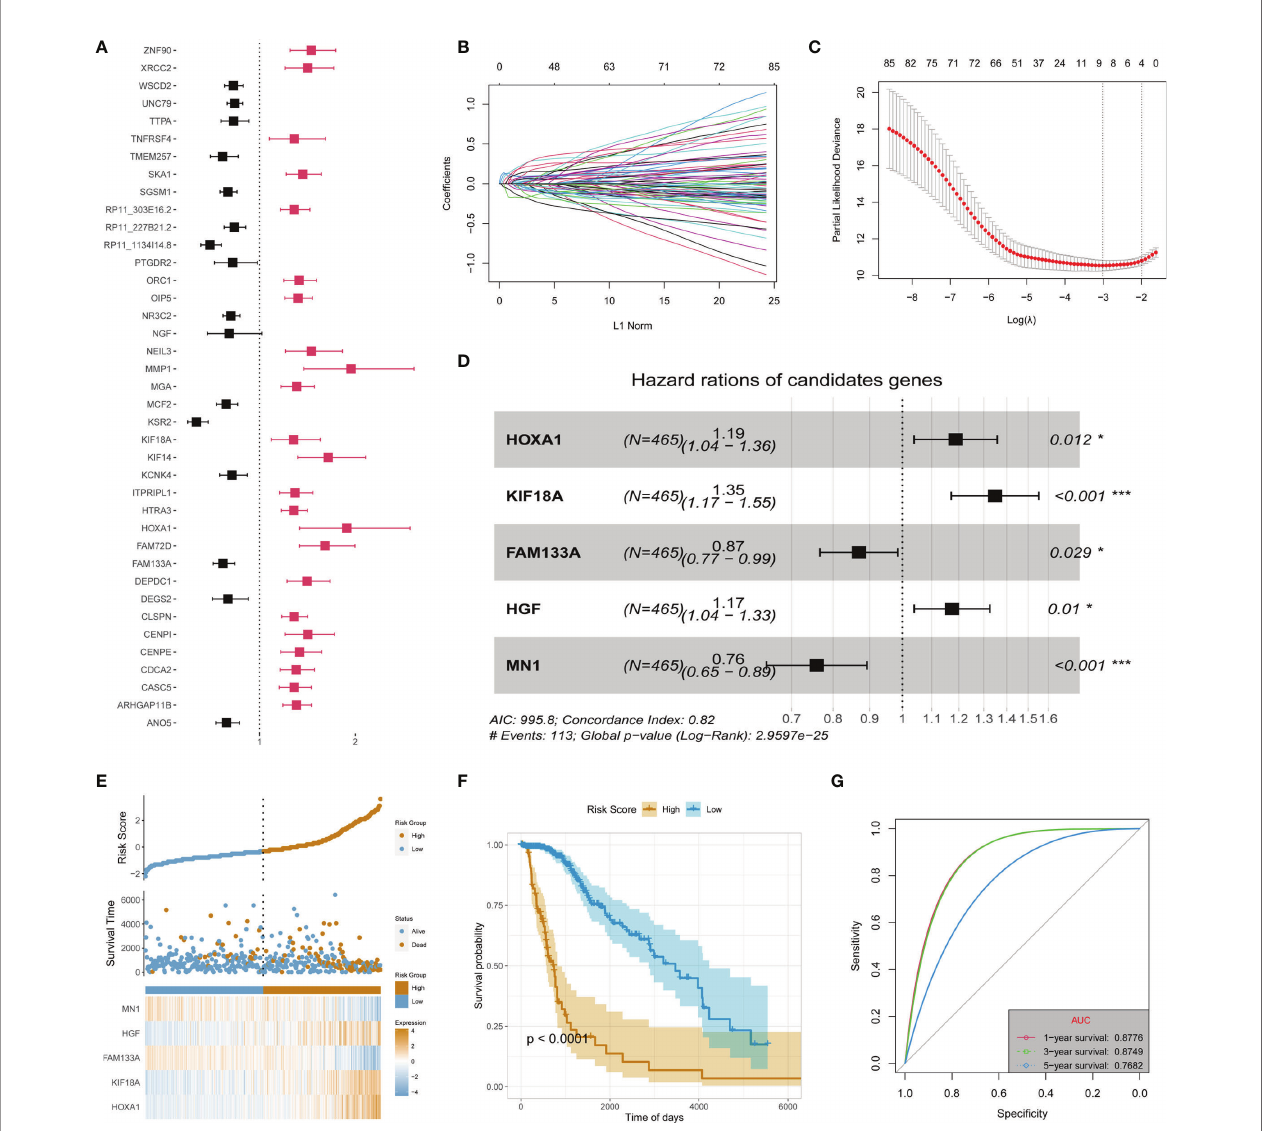
FIGURE 2 | Identi fi cation of main contributors of recurrence and malignant progression factors and construction of risk signature in TCGA-LGG cohort. (A) Univariate Cox analysis of all recurrence factors. (B) Cross-validation for tuning the coef fi cient selection in the least absolute shrinkage and selection operator (LASSO) regression. (C) LASSO regression of the 86 OS-associated genes. (D) Multivariate Cox regression analysis for the 5 genes. (E) Allocation of patients in the training set on the basis of the risk score. (F) Kaplan – Meier curves display the diversity in OS between the high-risk and low-risk groups in the training set. (G) Area Under the Curve (AUC) of time- dependent receiver operating characteristic (ROC) curves examined the prognostic performance of the risk score in the training set. "*" means 0.01<p<0.05, "***"means